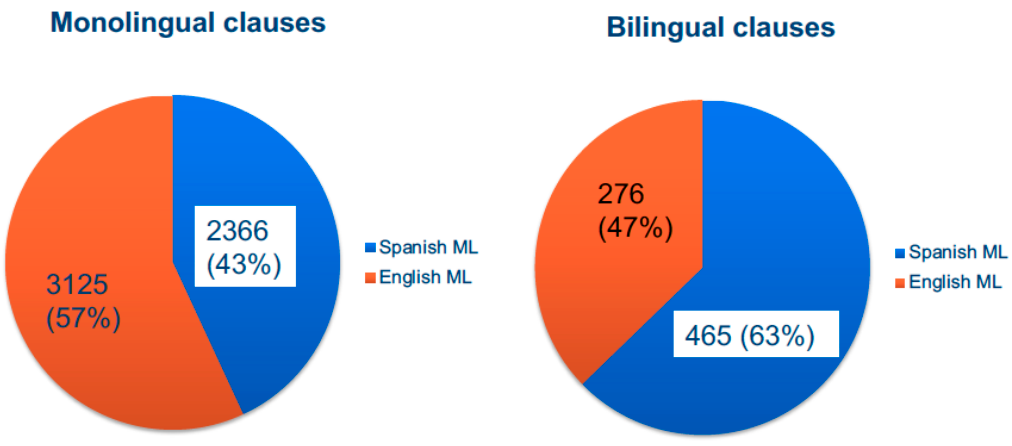
Figure 6. Quantitative distribution of matrix language in data from Miami Spanish / English community 5 .